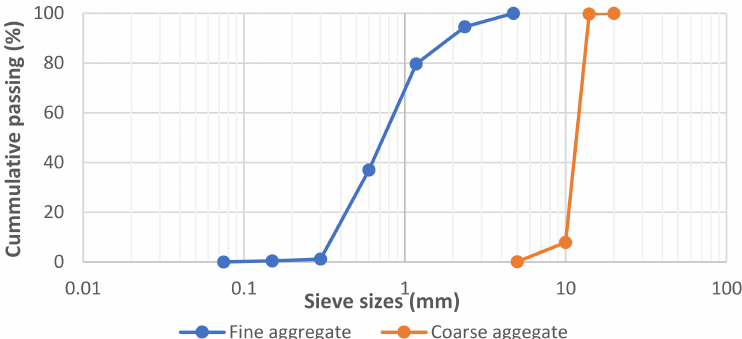
Figure 1. Particle size distribution of